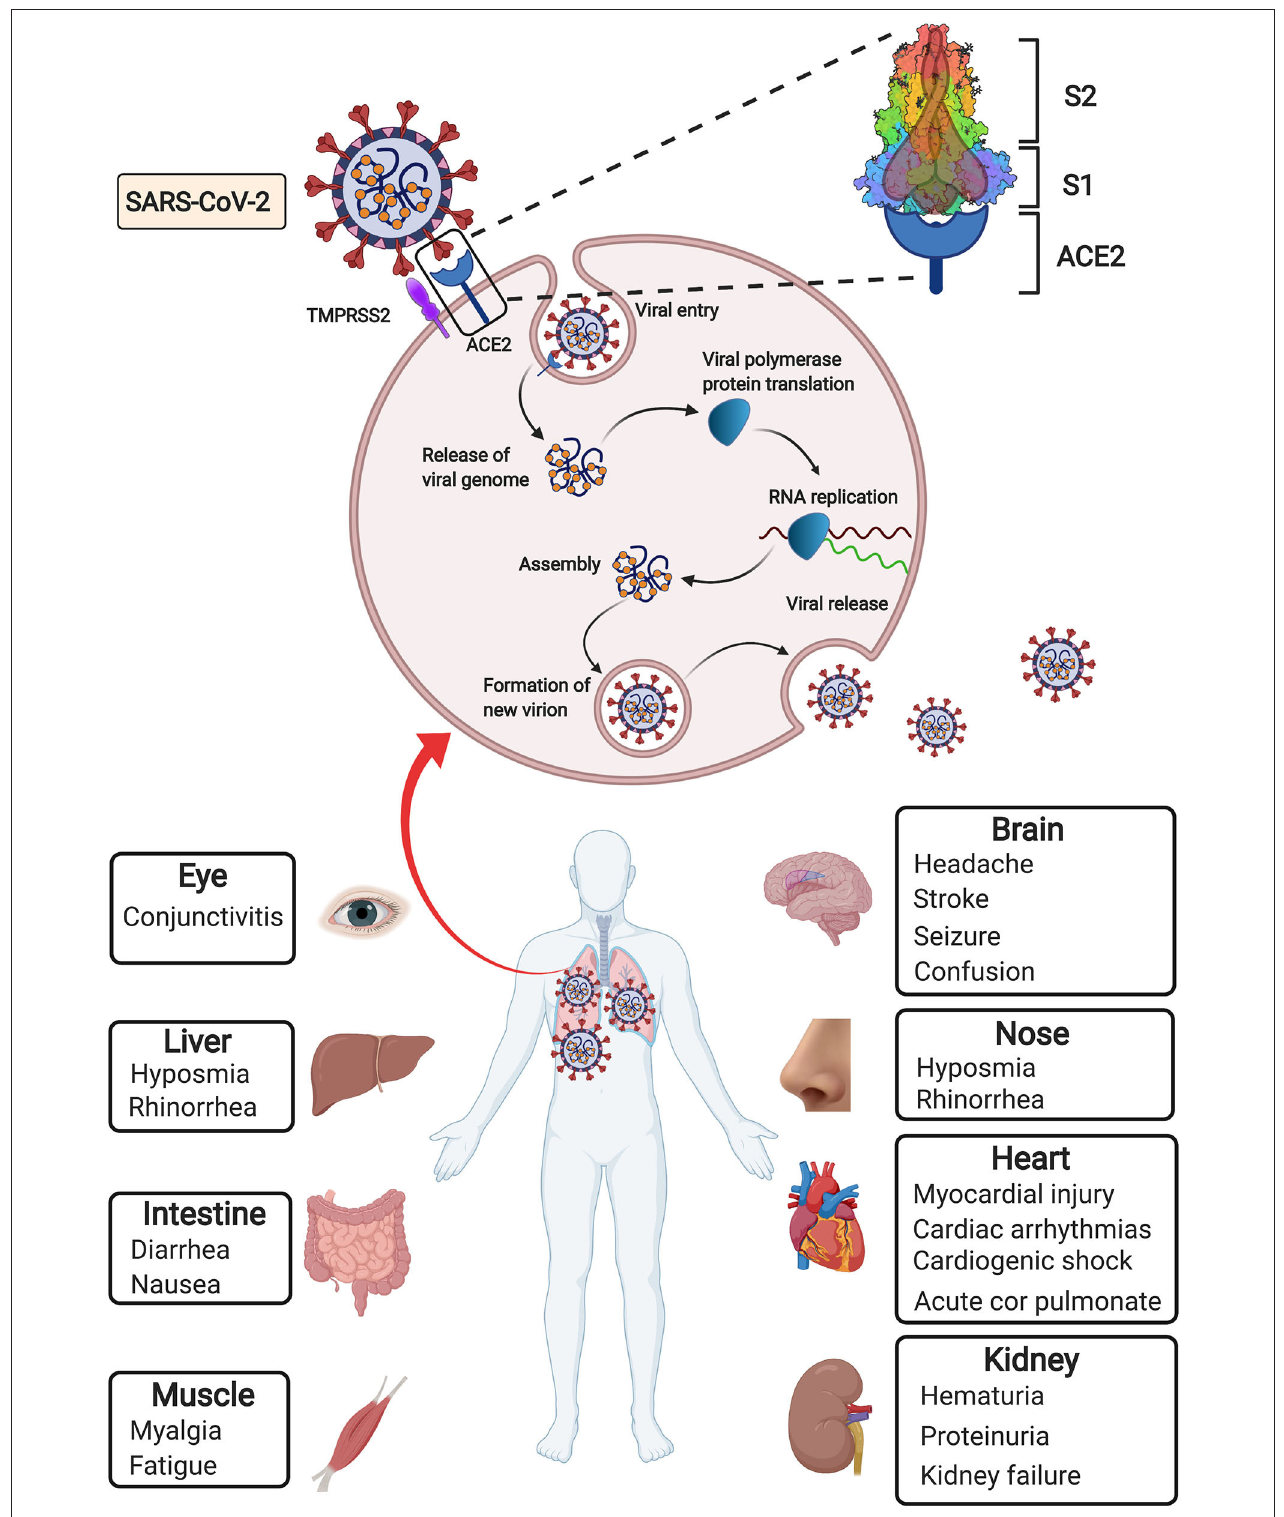
FIGURE 1 | Simplified depiction of SARS-CoV-2 lifecycle and extrapulmonary manifestations of COVID-19. SARS-CoV-2 enters host cells through interaction of its surface spike protein with the ACE2 receptor on the membranes of host cells in the presence of TMPRSS2, which mediates virus–cell membrane fusion and following viral entry. Then viral genomic RNA is released and translated into viral polymerase proteins. Viral RNA is assembled to form mature virions, followed by release of the new virions from the host cells. In addition to the most common pulmonary manifestation of COVID-19, extrapulmonary manifestations derived from many other injured organs have been